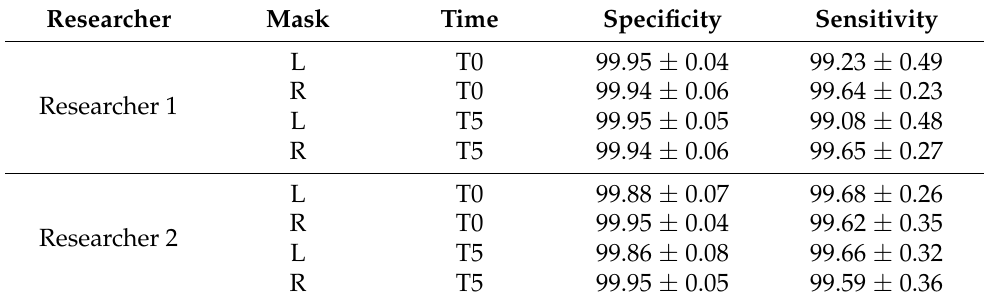
Table 2. Specificity and sensitivity provided by the Simultaneous Truth and Performance Level Estimation (STAPLE) algorithm for each researcher.